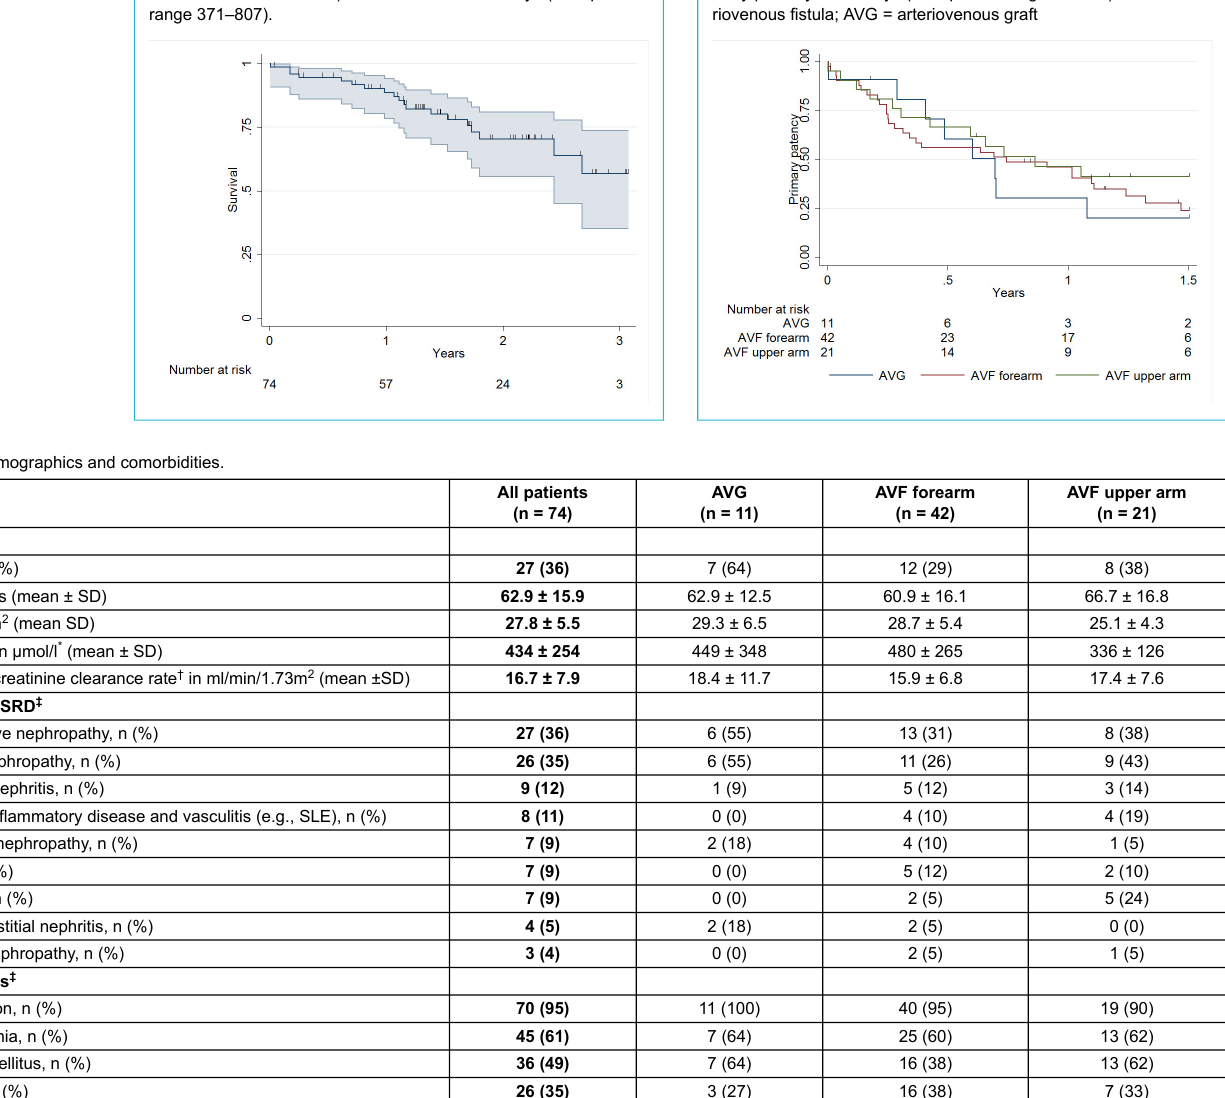
Figure 3: Patient survival after vascular access creation (including 95% confidence intervals): median survival 528 days (interquartile range 371–807).